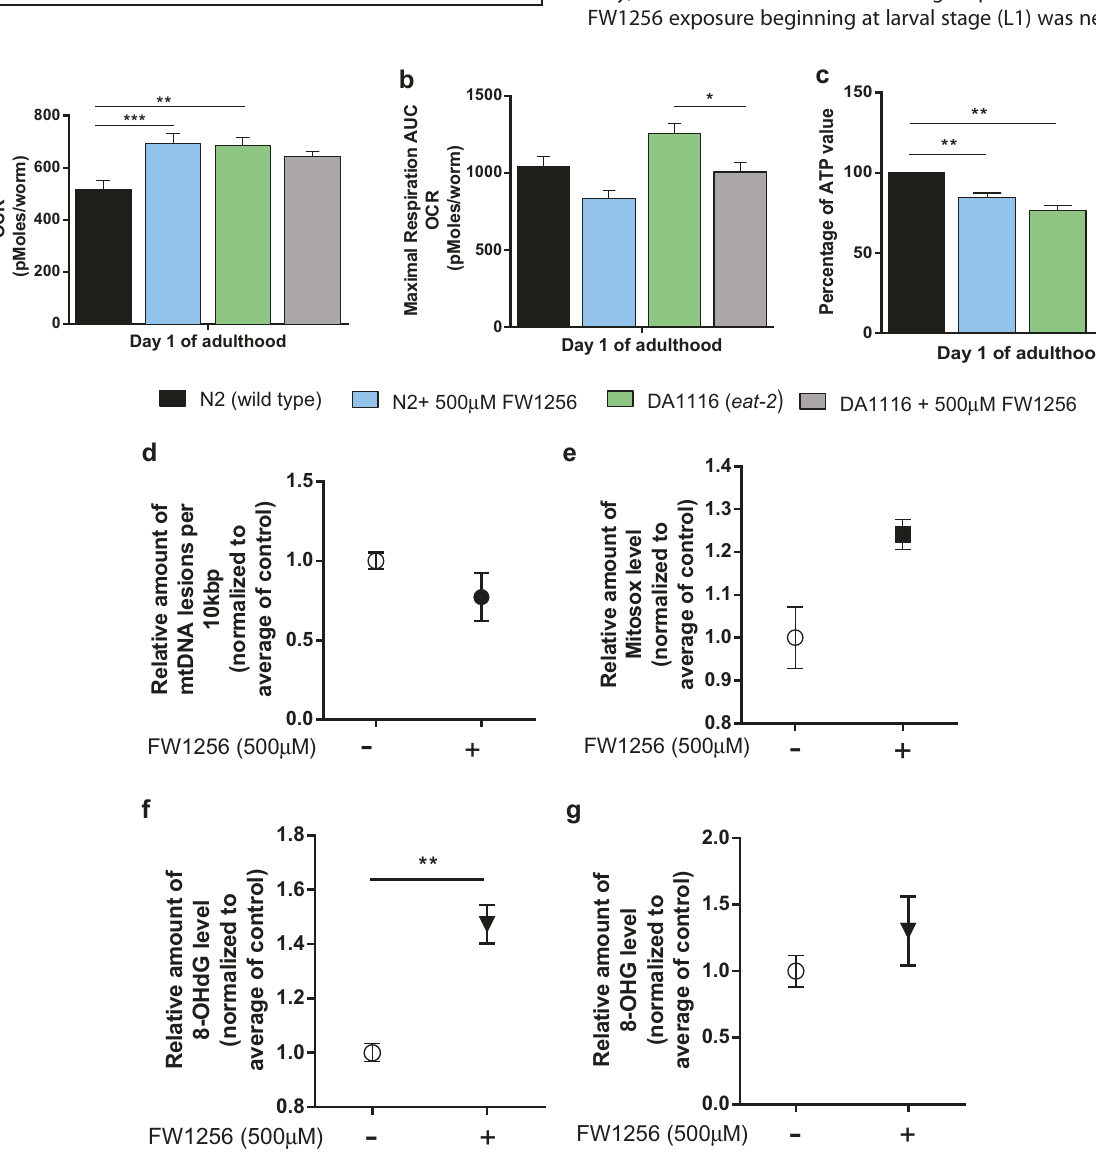
Fig. 5 Effects of FW1256 on metabolic pro fi les and oxidative stress in C. elegans . a – c Comparison of metabolic parameters in WT (unexposed), eat-2 mutants (unexposed), WT and eat-2 exposed to FW1256 (500 µM). a Basal respiratory capacity ( n = 3 biological repeats, one-way ANOVA with Bonferroni ’ s post-test, ** p < 0.01, *** p < 0.001), b maximal respiratory capacity ( n = 3 biological repeats, one-way ANOVA with Bonferroni ’ s post-test, * p < 0.05), c ATP levels ( n = 3 biological repeats, t -test, ** p < 0.01). d – g Measurement of oxidative stress in WT. d Mitochondrial DNA oxidative damage marker was measured by quantitative PCR ( n = 3 biological repeats, mean of three separate experiments normalized to average of control, t -test). e Reactive oxygen species (ROS) production determined by mitoSOX red fl uorescence ( n = 2 biological repeats, mean of two separate experiments normalized to average of control, t -test). f , g general oxidative DNA damage marker, 8-OHdG ( f ) and oxidative RNA damage marker, 8-OHG ( g ) normalized to average of control ( n = 3 biological repeats, t -test, ** p <